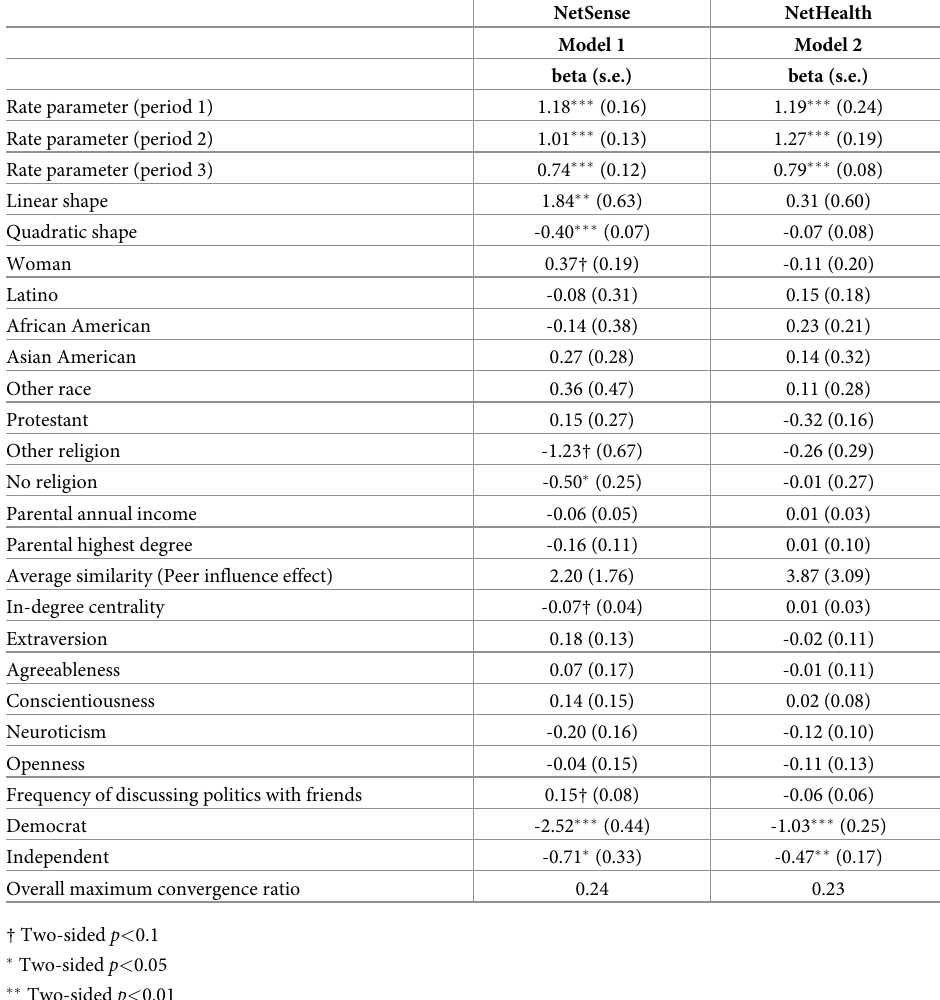
Table 6. The political orientation equation in estimated SAO models for the NetSense and NetHealth study